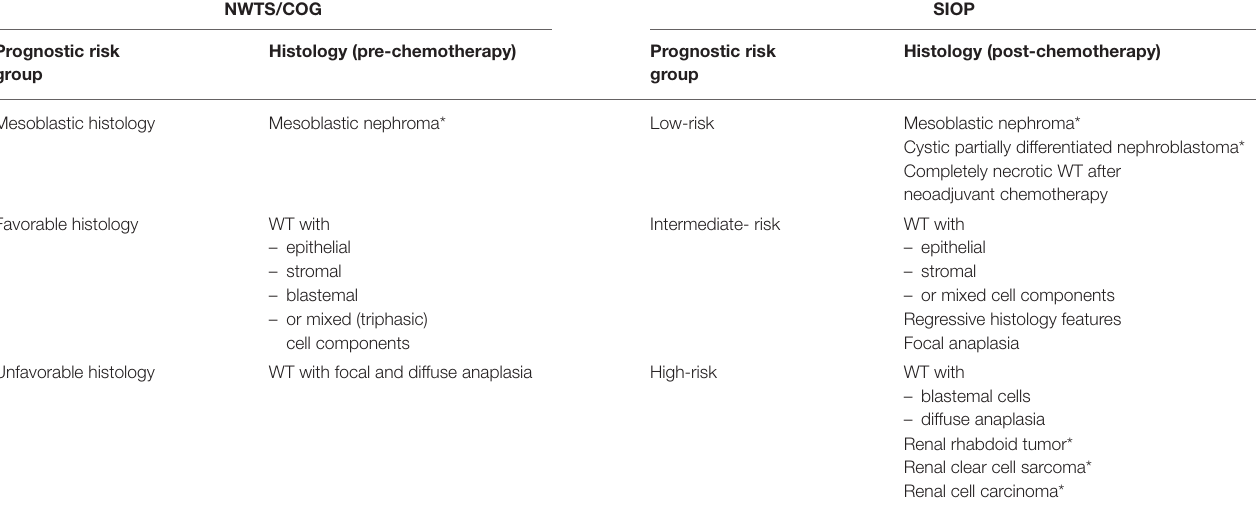
TABLE 2 | Prognostic risk groups for WT according NWTS/COG and SIOP relating to the histopathology of embryonal renal tumors in